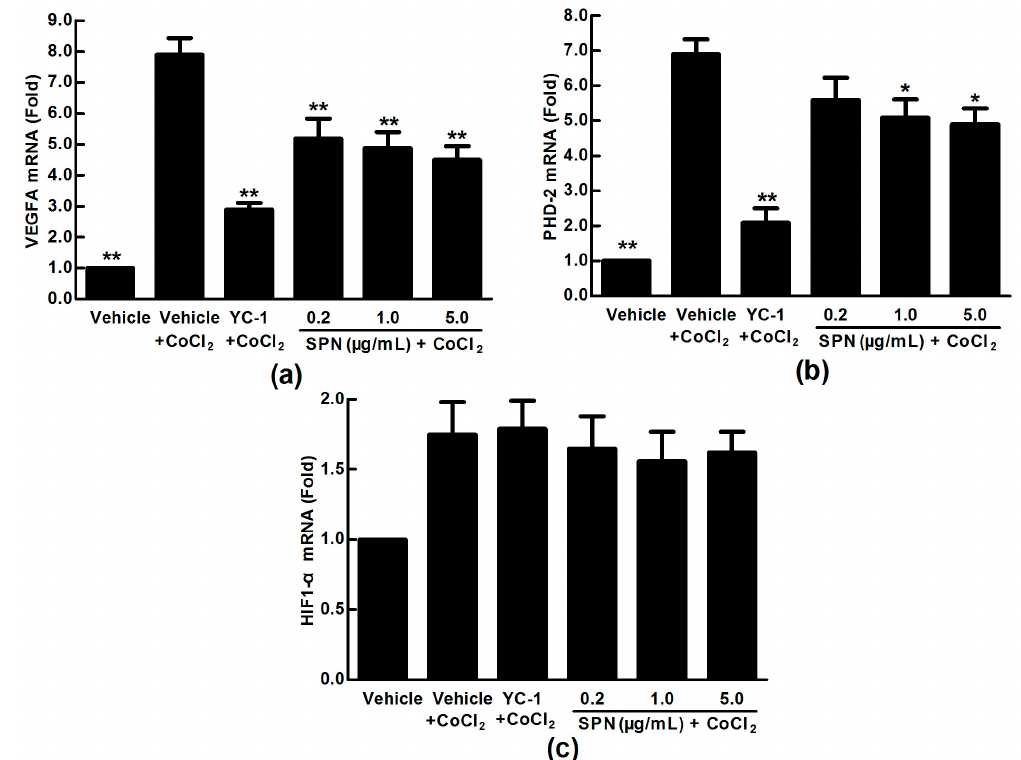
Figure 3. Effects of SPN on the mRNA expressions of VEGFA, HIF-1 α and PHD-2 in ARPE-19 cells